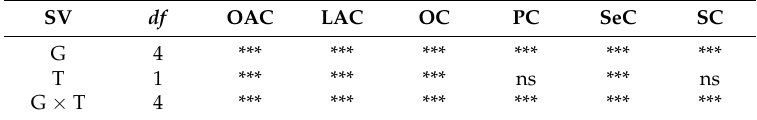
Table 3. Effects of Drought Treatment on Seed Quality Traits of Five Sesame